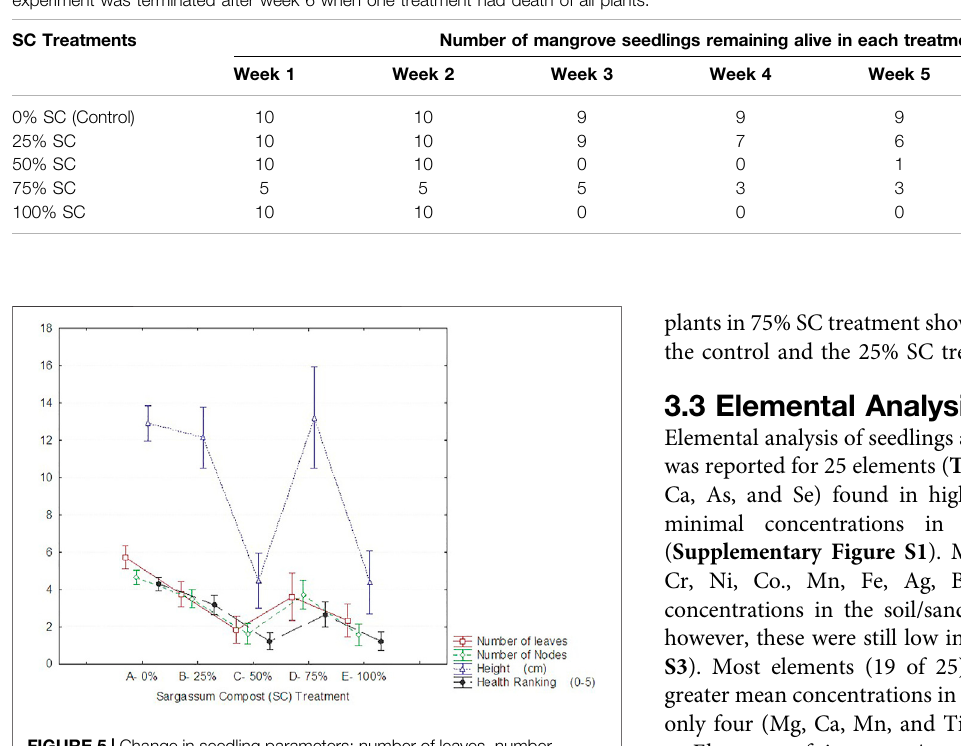
FIGURE 5 | Change in seedling parameters; number of leaves, number ofnodes, height,and health(means with±95%CI)acrossSCtreatmentinthe “ wet ” nursery averaged for all